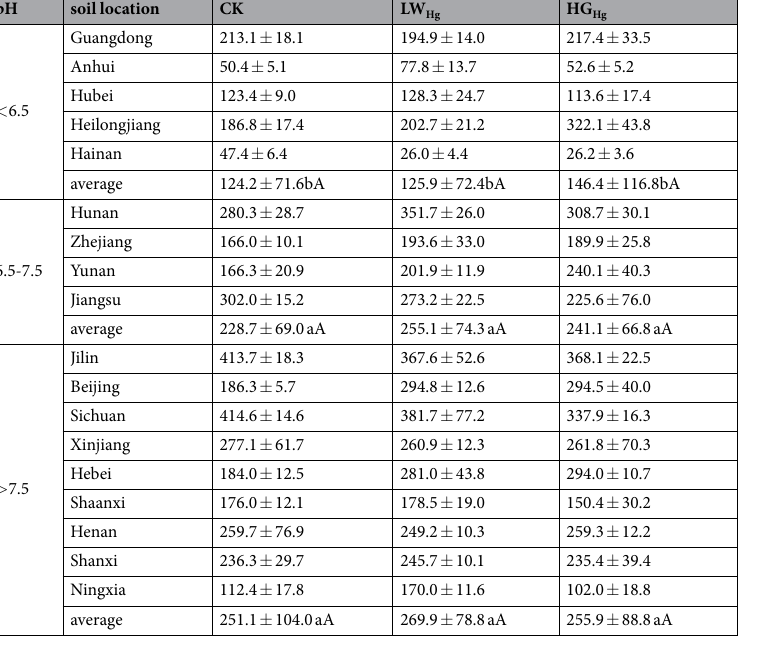
Table 5. Effect of treatments on potato yields in pots with different soils (pH < 6.5, 6.5 < pH < 7.5, pH > 7.5) with three different Hg concentrations at the end of the experiment. * Mean ± SD, different small letters within the same column and different capital letters within the same row for each treatment indicate a significant difference at p < 0.05 by Student’s multiple range